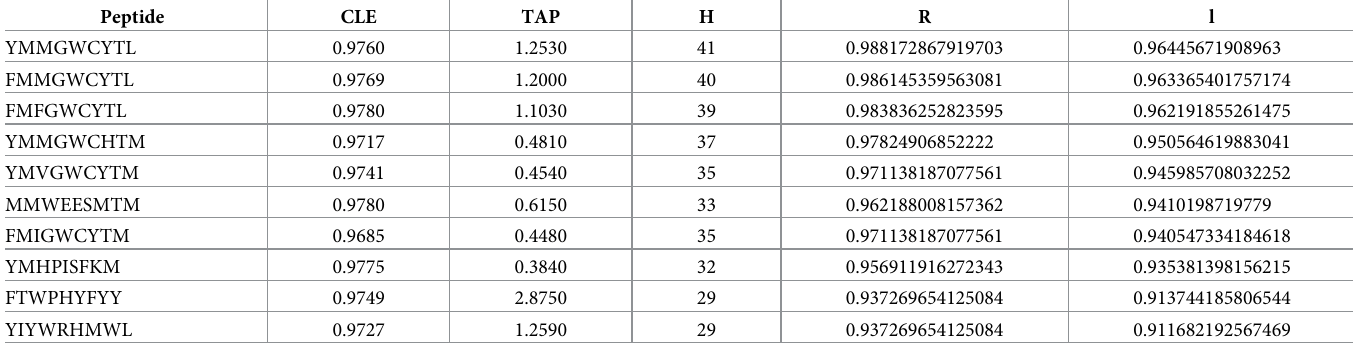
Table 6. Ranking of the most promising peptides selected from the set W 4 for Trypanosoma cruzi. Peptide CLE TAP H R